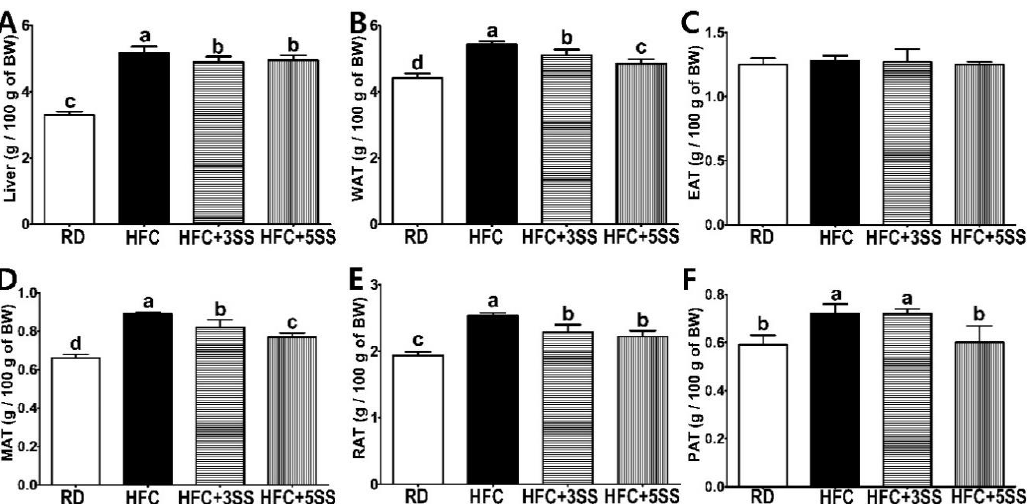
Figure 2. Effects of Stachys sieboldii Miq. root powder (SS) on hepatomegaly and adiposity. Experimental rats were fed a regular diet (RD) or a high-fat and high-cholesterol (HFC) diet with or without Stachys sieboldii Miq . root powder (SS; 3 or 5%) supplementation for 6 weeks. ( A ) Relative liver, ( B ) white adipose tissue (WAT), ( C ) epididymal adipose tissue (EAT), ( D ) mesenteric adipose tissue (MAT), ( E ) retroperitoneal adipose tissue (RAT) and ( F ) perirenal adipose tissue (PAT). Relative tissue weights were calculated as g/100 g of BW. RD, regular diet; HFC, high-fat and high-cholesterol diet; HFC + 3SS, High-fat and high-cholesterol diet + 3% of Stachys sieboldii Miq . root powder; HFC + 5SS, high-fat and high-cholesterol diet + 5% of Stachys sieboldii Miq . root powder. Values are means ± standard deviation, n = 8. Data were analyzed using one-way ANOVA followed by Tukey’s post hoc test. Means labeled without a common letter differ significantly, p < 0.05.